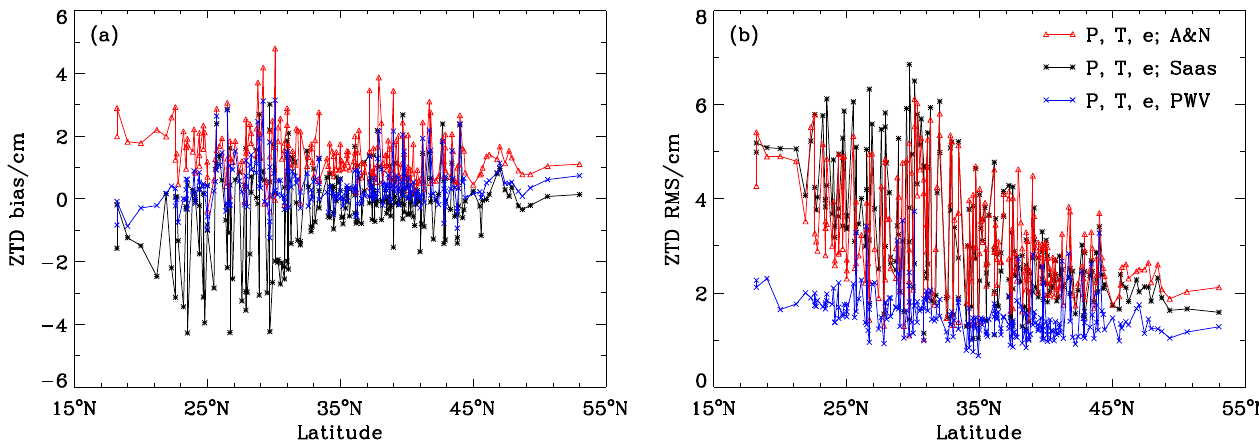
Figure 9. Bias ( a ) and RMS ( b ) values of the differences between GNSS-ZTDs and ZTDs derived from ERA surface analysis data (2.5° × 2.5°) over 237 CMONOC stations in China during 2015. The red line and black line indicate results of ZTDs obtained from derived P , T , and e with the A&N model and the Saas model respectively, while the blue line indicates results of ZTDs obtained from derived P , T , e , and PWV.